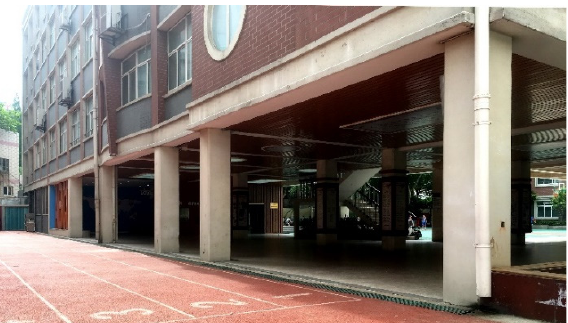
Figure 15. The lift-up building in Chibi Road Primary School (Shanxi Road Campus).